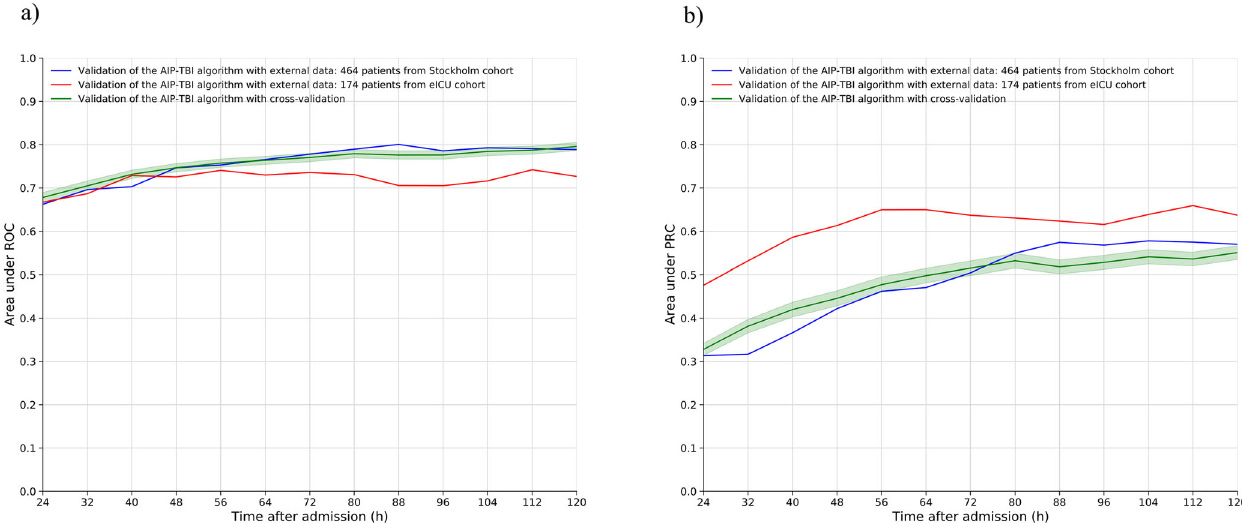
Fig. 4 Time-dependent area under receiver operating curves (AUC) and area under the precision recall curves (AUPRC). Time-dependent AUCs ( a ) and time-dependent AUPRCs ( b ). The fi rst AUC and AUPRC values are calculated after 24 h after which a new value is calculated for every 8 h. In green, the cross-validation results from the algorithm retraining, in blue, the results from the Stockholm cohort validation and in red, the results from the eICU cohort validation. The increase in AUC was more pronounced in the Stockholm cohort than in the eICU cohort, whereas the increase in AUPRC was more pronounced in the eICU cohort than in the Stockholm